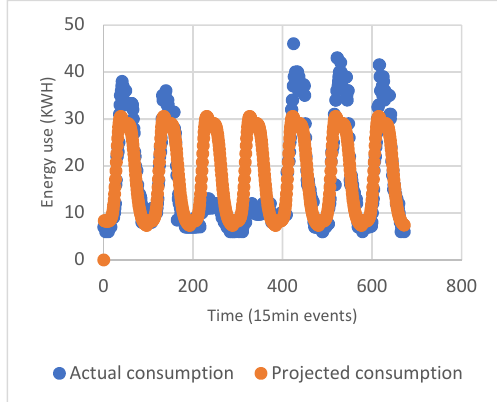
Figure 6. A comparison of how varying the number of hidden layers impacts ANN predictions.